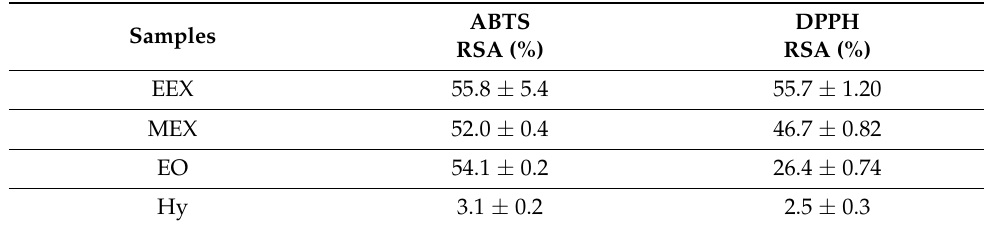
Table 5. Antiradical power of EEX and MEX.